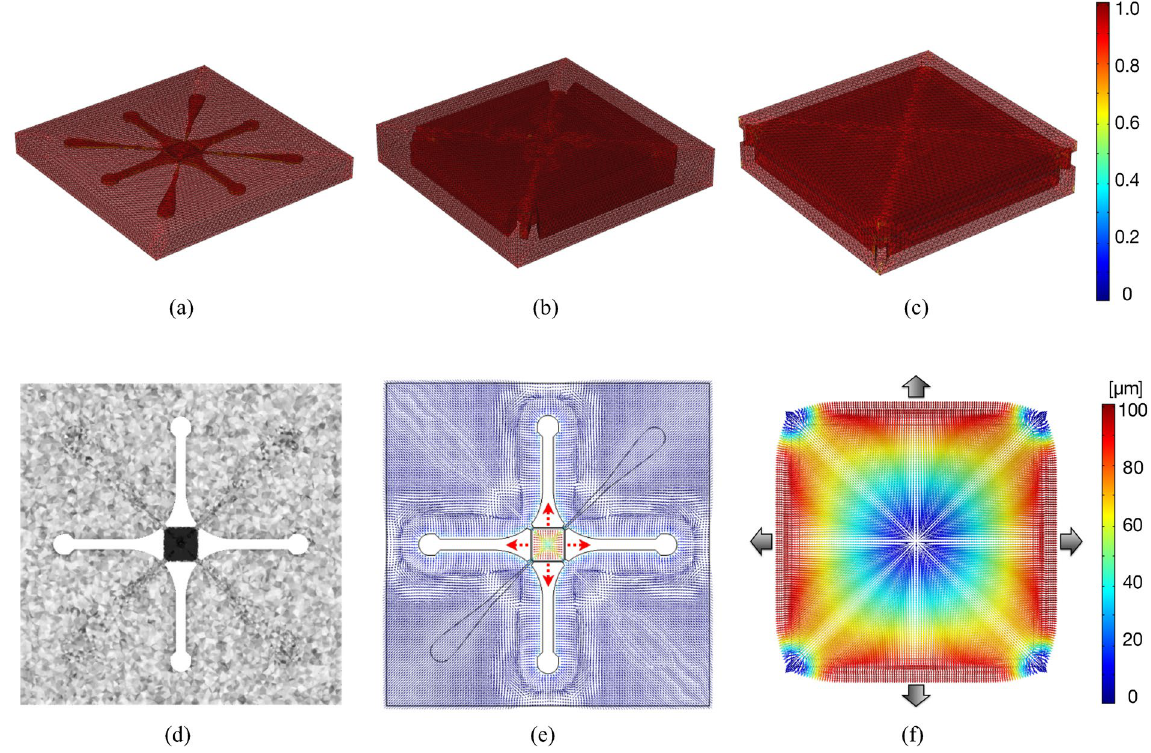
Figure 2. Computational model. ( a–c ) Mesh element quality distribution over the entire MCD (a) and two progressive zoomed views of the culture chamber ( b,c ). Colour code refers to tetrahedral mesh quality (1 represents the highest quality). ( d,e ) Mesh distribution ( d ) and arrow plot of the displacement field ( e ) along the mid-planar section for the entire device. ( f ) Zoomed view on the displacement field on the PM (the equibiaxial loading case is highlighted by pressure